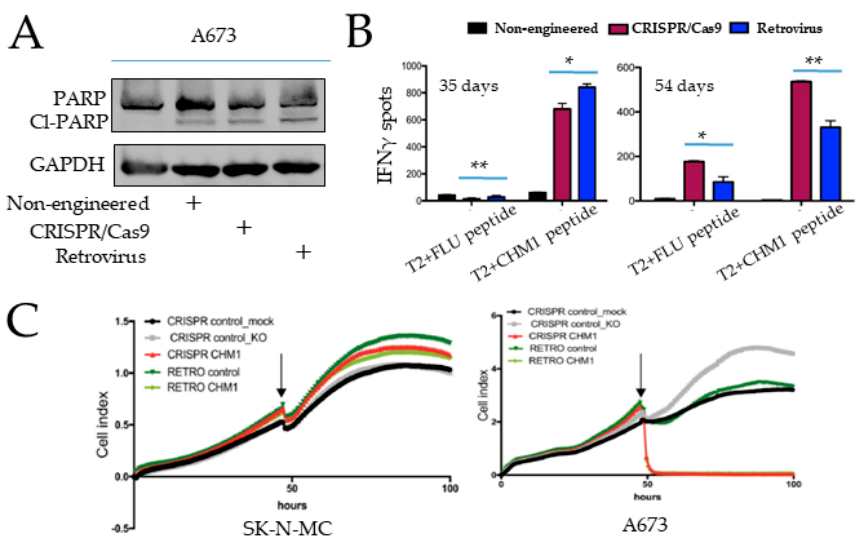
Figure 5. Adoptive transfer of CHM1 319 -TCR transgenic T cells-treated tumor-bearing Rag2-/- γ C-/- mice. ( A ) Determination of cl-PARP in A673 (HLA-A*02:01+/CHM1+) cells by SDS-PAGE after co- culture of A673 cells with either no T cells, non-engineered T cells, engineered T cells with orthotopic TCR replacement, or retroviral transduction. ( B ) Evaluation of activation of T cells by IFN γ -ELISpot assay after co-culture with T2 cells plus CHM1 peptide on 35 days (left) and 54 days (right) after T cell isolation from PBMC. A total of 1000 T cells were used in the experiments. ( C ) xCELLigence detachment assays were performed with a different donor to compare the cytotoxic effect of T cells on HLA-A*02:01+/CHM1- SK-N-MC and HLA-A*02:01+/CHM1+ A673 cells. Treatment groups include T cells without CRISPR/Cas9 engineering but otherwise undergoing an identical procedure, including electroporation (CRISPR control_mock), T cells with CRISPR/Cas9-engineered TCR KO only (CRISPR control_KO), T cells with CRISPR/Cas9-engineered TCR KO and TCR replacement (CRISPR CHM1), T cells without retroviral TCR transduction but otherwise identical procedures, including ultracentrifugation (RETRO control) and T cells with retroviral TCR transduction (RETRO CHM1) on day 20. Error bars represent standard deviation of triplicates experiments. * means p < 0.05, ** means p < 0.01.